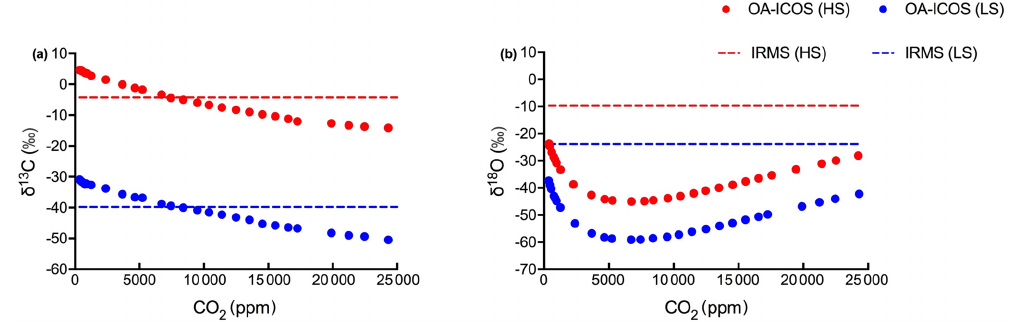
Figure 4. Variability observed in (a) δ 13 C and (b) δ 18 O measurements using OA-ICOS before calibration. δ 13 C and δ 18 O measured using OA-ICOS for heavy standard and light standard are shown as red and blue circles respectively. Actual δ 13 C and δ 18 O values reported after measuring by IRMS for heavy standard and light standard are shown as red and blue dashed lines